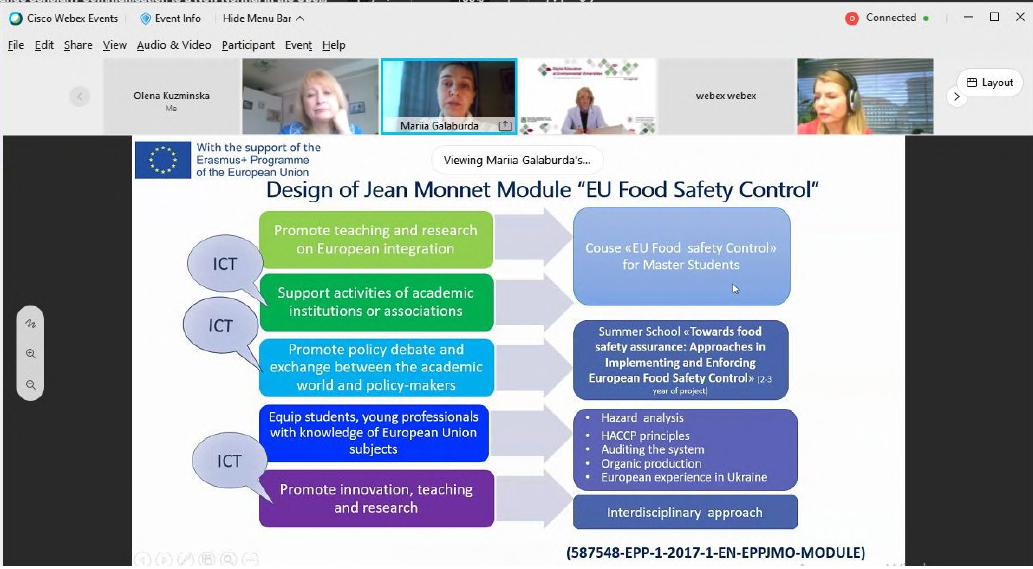
Figure 48: Presentation of paper